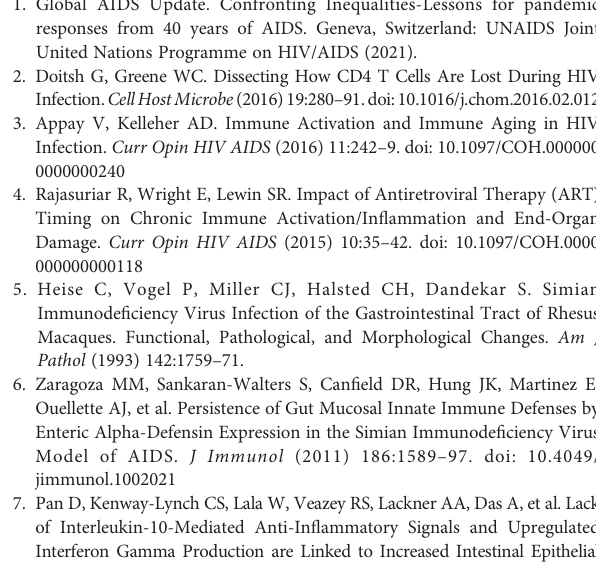
real-time PCR. No statistically signi fi cant differences in plasma viral load between different routes of infection were detected as analyzed with Mann- Whitney t-test. Supplementary Figure 2 | Amplicons from RT-PCR using the RhM jejunum crypts cDNA ( A , upper panel) and enteroids cDNA ( B , lower panel). PCR products were separated by electrophoresis on 1.5% agarose gel and visualized with ethidium bromide staining. Each lane represents the different amplicons resulting from the reactions with gene-speci fi c primers for LGR5 (232bp), OLFM4 (143bp), Vil1 (120bp), MUC2 (113bp), LGR4 (202bp), FOXA2 (270bp), SPON1 (231bp), no cDNAnegative control(with GAPDH primers), andGAPDH positive control(120bp). A 50bp DNA ladder was used for reference. Supplementary Figure 3 | Representative immuno fl uorescence images of the jejunumshowingthedistributionofLGR5+ cellsandHD5(Panethcells, A ),epithelial cells (Cytokeratin, B ) and adherens junction protein (E-cadherin, C ) from a normal uninfected RhM. (A) The white lines show the orientation of crypts in this jejunum section. (D) DistributionofHD5+cellsareshownfromanormalSIV-uninfected RhM where the HD5+ Paneth Cells are located at the base of the crypts. Note that the colocalization of LGR5+ cells and epithelial cells (detected by E-cadherin or Cytokeratin) was shown by yellow color (yellow arrows). Supplementary Figure 4 | Scatter plots of LGR5+ (A) and HD5+ (B) cells are shown for jejunum in male (n=6) and female (n=5) SIV-uninfected control RhMs. The number of LGR5+ and HD5+ cells was quanti fi ed from 19-20 randomly selected fi elds and the number of positive cells in each fi eld was depicted as a single point in the scatter plot. The larger horizontal line denotes the mean frequencies (+/- standard deviation) of each category. No statistically signi fi cant differences of LGR5+ or HD5+ cells among male and female macaques were detected with Mann-Whitney T-test. Supplementary Figure 5 | The representative fi gure depicts the gating of region of interest (ROI) for Ki67 staining. The ROIs were manually drawn in the epithelium from randomly selected crypts (highlighted with yellow, and marked as 1, 2, and 3) for the quanti fi cation of Ki67 in epithelial cells. Supplementary Figure 6 | Development of fully grown enteroids isolated from single jejunum crypts on day 13th in both uninfected and chronic SIV infected rhesus